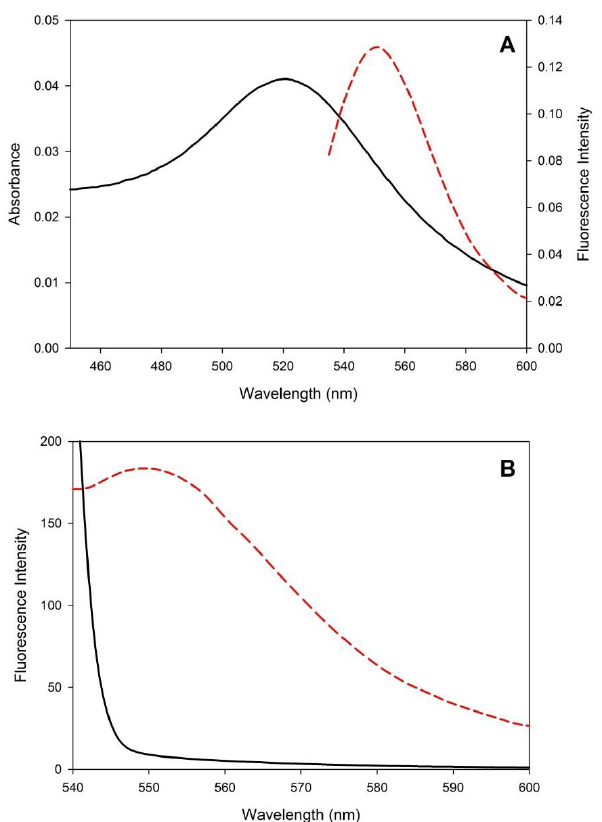
Figure 2. ( A ) Normalized absorption spectrum of a solution of AuNPs 1.29 × 10 −9 mol·L –1 (black solid line) and normalized emission spectrum ( λ ex = 528 nm) of a solution of FC1 1 μmol·L –1 (red dashed line), both solutions prepared in water:MeOH (80:20, pH = 7); and ( B ) fluorescence emission spectra of a solution of FC1 1 μmol·L –1 before (red dashed line) and after (black solid line) the addition of 50 μL of AuNPs 5.17 × 10 −8 mol·L –1 ( λ ex = 528 nm).